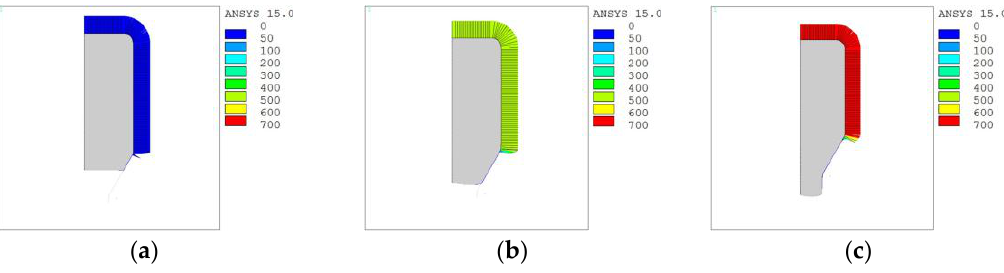
Figure 3. Fluid pressure distribution at ( a ) initial stage, ( b ) pressure-up stage and ( c ) stable stage.